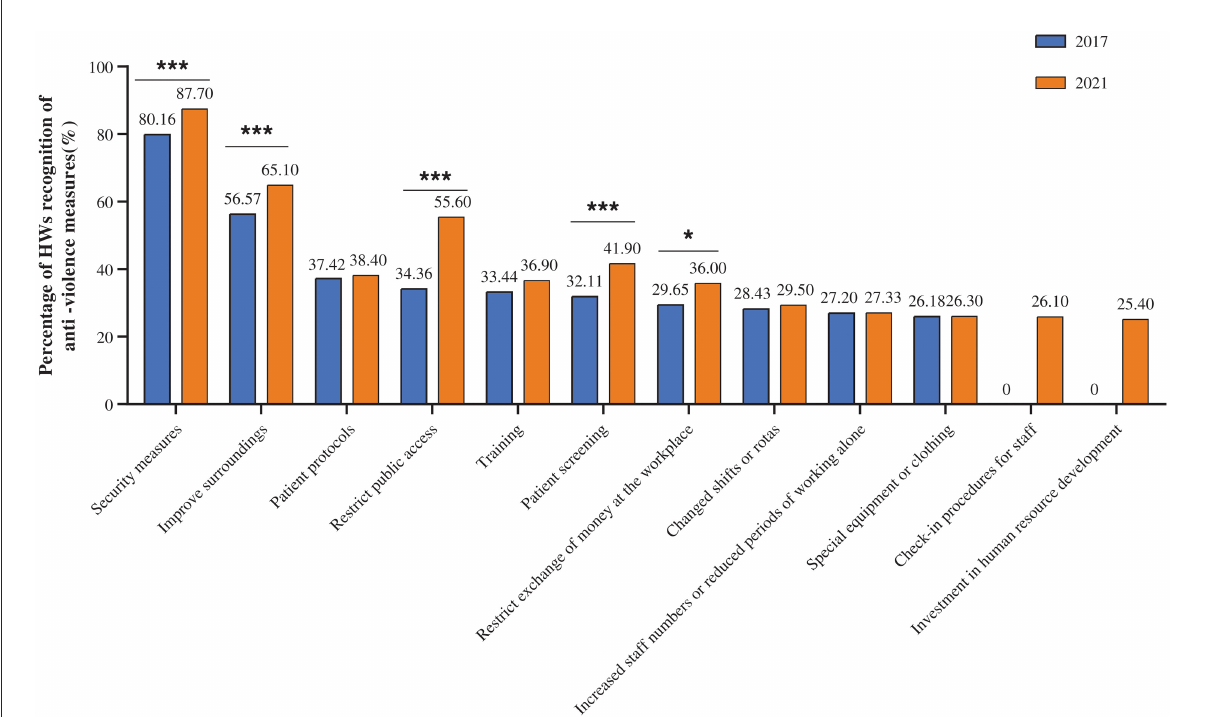
FIGURE3 Statistical chart of the percentage of recognition of anti-violence measures in the workplace. Both 2017 and 2021 in the figure refer to the year. In both surveys, security measures ranked first in terms of recognition. The recognition of restricting public access showed the largest increase. ***indicates that P < 0.001. *indicates that P < 0.05. Security measures, Pearson’s Chi square = 20.434, P < 0.001; Improve surroundings, Pearson’s Chi square = 13.682, P < 0.001; Restrict public access, Pearson’s Chi square = 86.568, P < 0.001; Patient screening, Pearson’s Chi square = 19.658, P < 0.001; Patient protocols, Pearson’s Chi square = 0.209, P = 0.647; Restrict exchange of money at the workplace, Pearson’s Chi square = 8.736, P < 0.05; Increased staff numbers or reduced periods of working alone, Pearson’s Chi square = 0.001, P = 0.971;